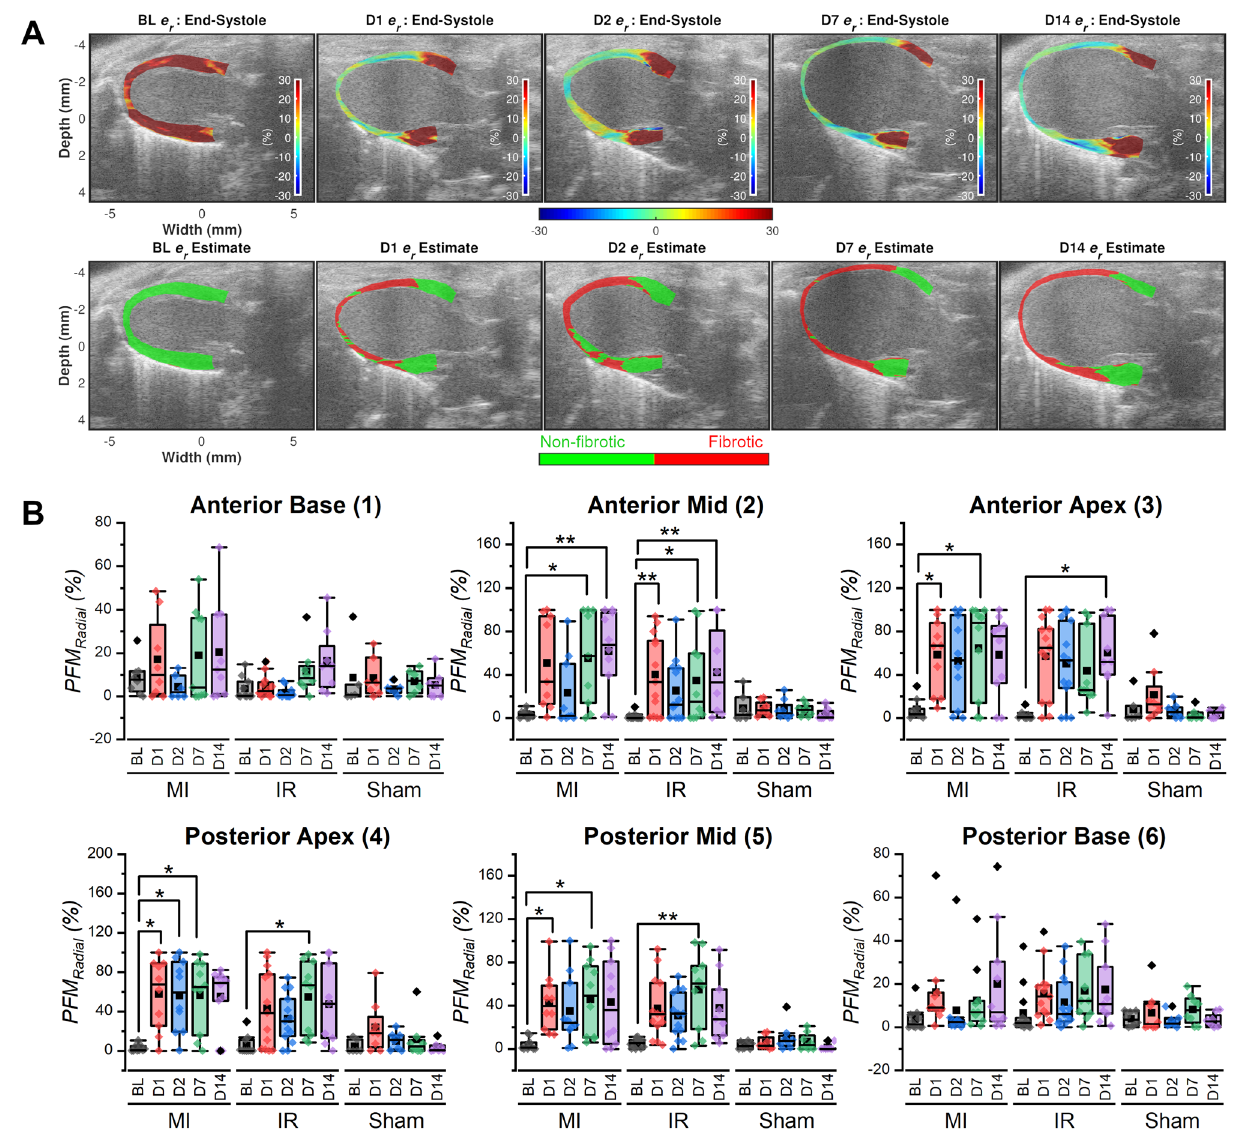
Figure 2. Monitoring cardiac remodeling using ES radial strain images. ( A ) Top row: Temporal progression of ES radial strain images from BL to Day 14 (D14) in a female BALB/CJ mouse after MI surgery. Strain display dynamic range is from − 30 to + 30%. Positive strain value (red) = myocardial wall thickening, negative strain value (blue) = myocardial wall thinning and zero strain value (light green) = no wall motion. Bottom row: Cardiac fibrosis maps estimated using ES radial strain images presented on the top row. Red = fibrotic region, green = non-fibrotic region. ( B ) Top row: Box and whisker plots demonstrating temporal variation and inter-group comparison [MI (n = 10), IR (n = 13) and Sham (n = 8)] of percentage fibrotic myocardium (PFM) estimated from radial strain ( PFM Radial ) in the anterior myocardial segments. Bottom row: Box and whisker plots demonstrating temporal variation and inter-group comparison (MI, IR and Sham) of PFM Radial in the posterior myocardial segments. Friedman’s test with Bonferroni–Dunn post hoc test was used. Symbol definitions: BL—Baseline, D1—Day 1, D2—Day 2, D7—Day 7, D14—Day 14, Squares—mean, Diamonds—outliers, whiskers—1.5 × IQR (Inter-quartile range), box—25th to 75th percentiles, * p < 0.05, ** p < 0.01, *** p <